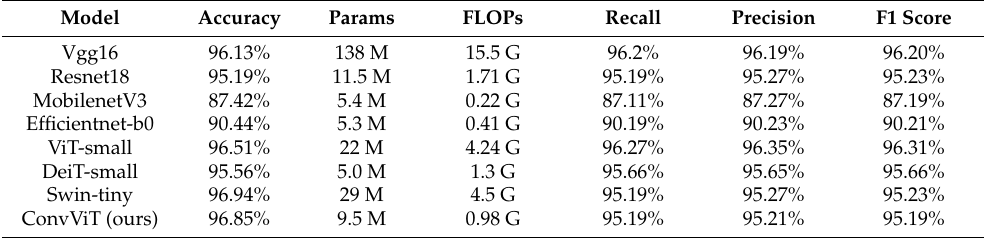
Table 3. Specific experimental metrics for comparison with the state-of-the-art methods.